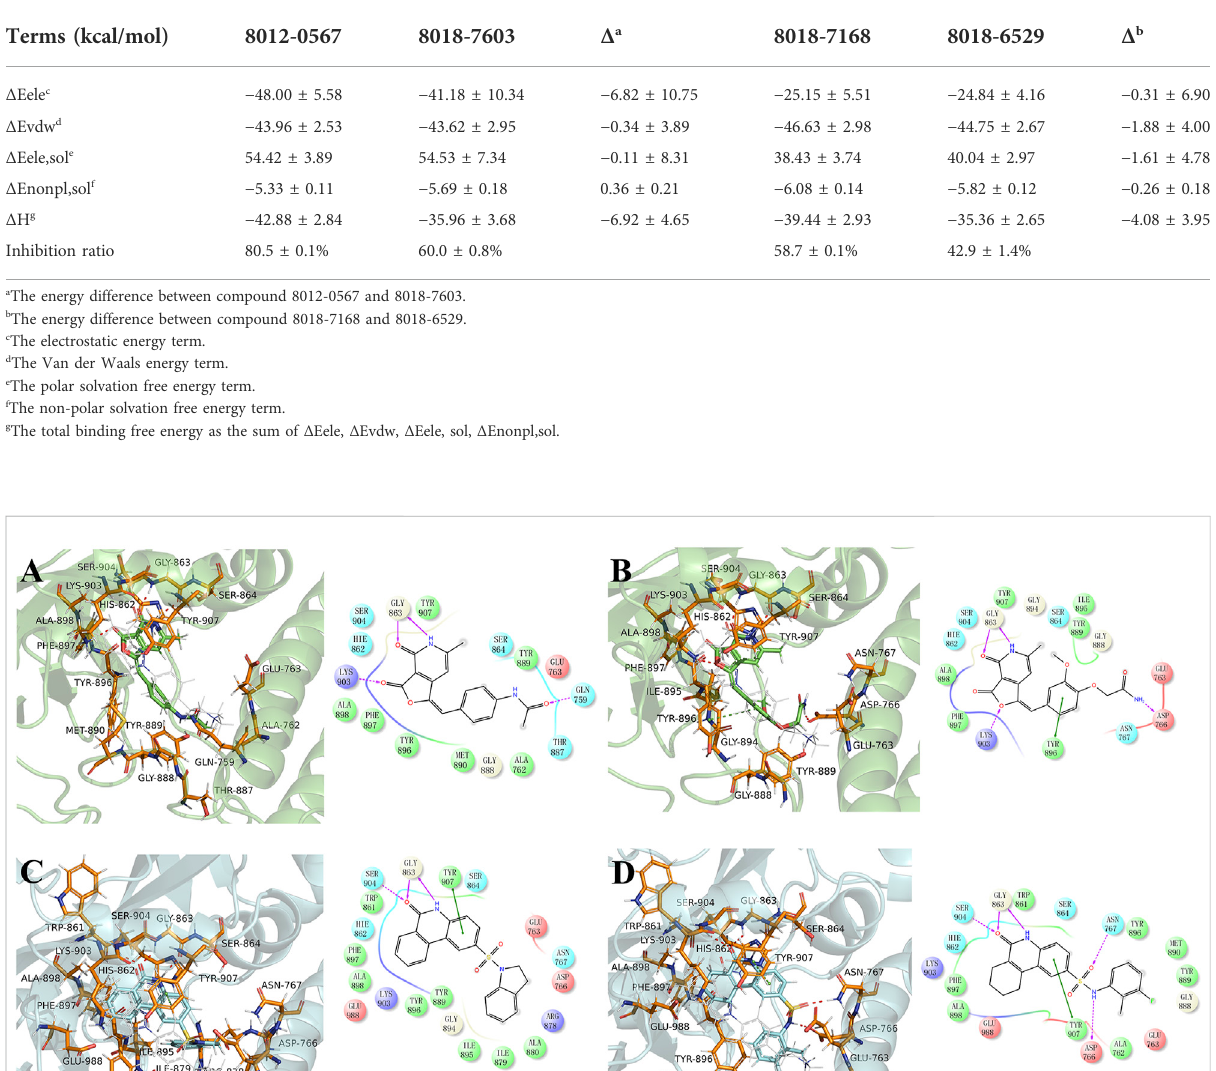
TABLE 2 The binding free energies of four hit compounds evaluated by MM/GBSA.